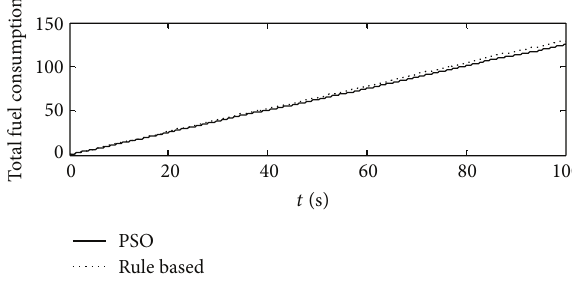
Figure 11: The comparisons of total fuel consumption between PSO optimal control and rule-based one.